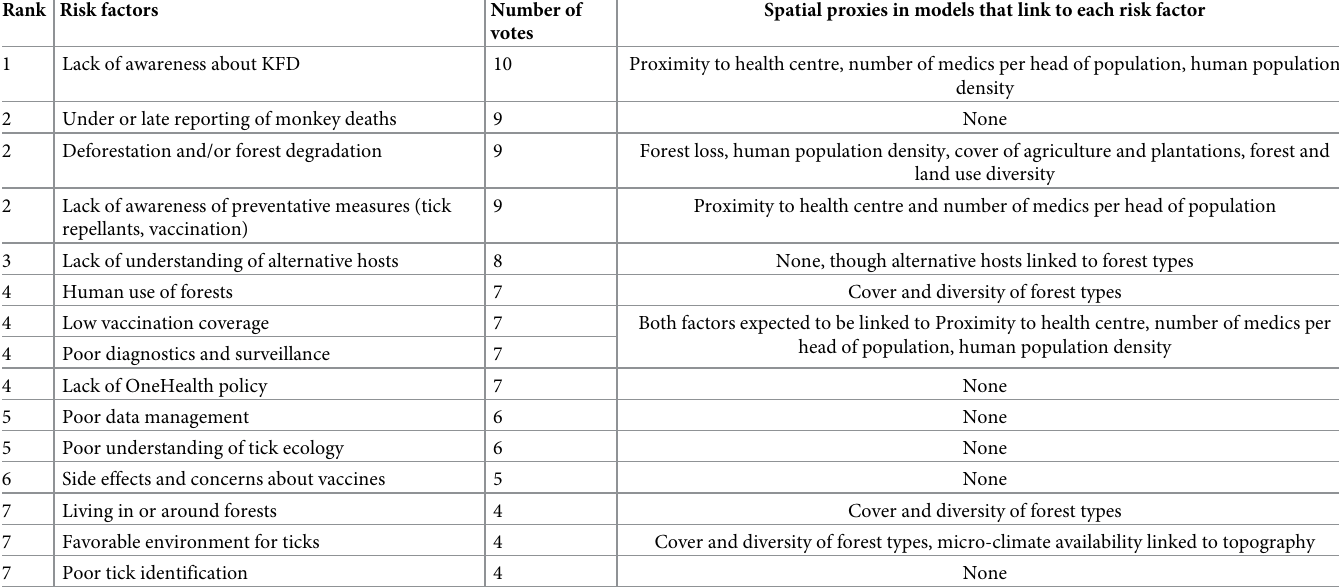
Table 1. Ranked list of key risk factors for Kyasanur Forest Disease produced by cross-sectoral stakeholders during the MonkeyFeverRisk Problem Framing workshop.